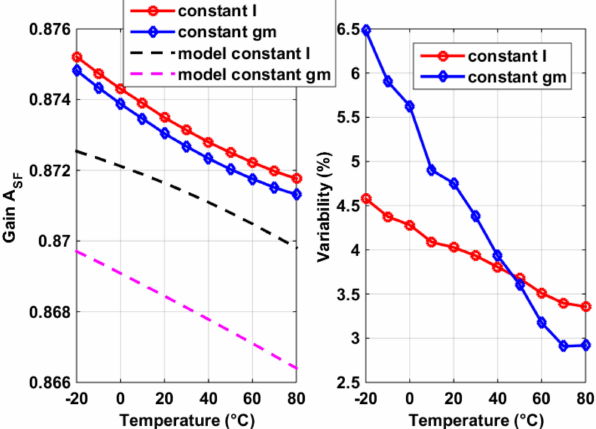
Figure 11. ( Left ): Measurement results of the A SF and its temperature dependency ( left ), compared with its modeled results using the process sensors’ g m,SF , for the constant current and constant g m bias circuits, respectively. ( Right ): The 1 σ process variability of measured A